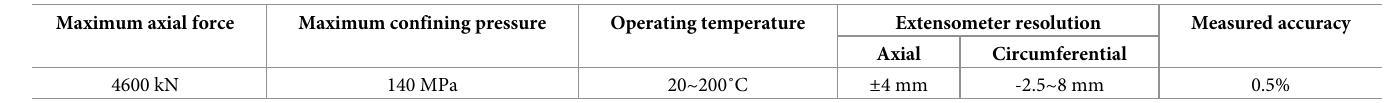
Table 1. Specifications of MTS815.